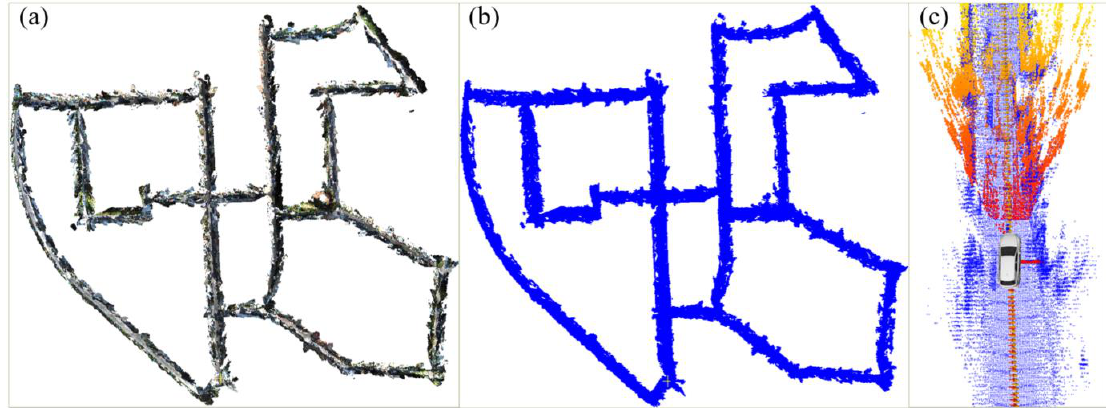
Figure 5. Localization process of different stages by the proposed method with the sequence 00 of the KITTI dataset. ( a ) Dense prior visual point cloud map; ( b ) priori visual point cloud map after downsampling; ( c ) local enlargement of localization result.